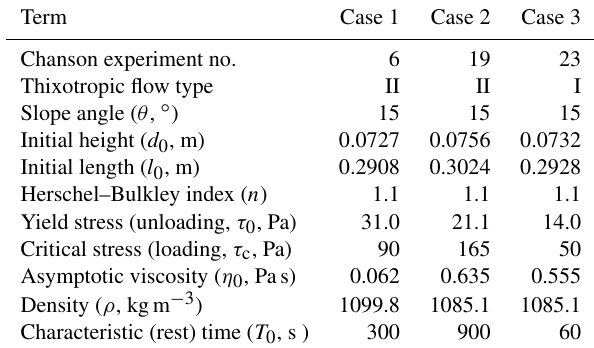
Table 2. Dimensions and data for thixotropic avalanche simulations corresponding with experiments by Chanson et al. (2006).